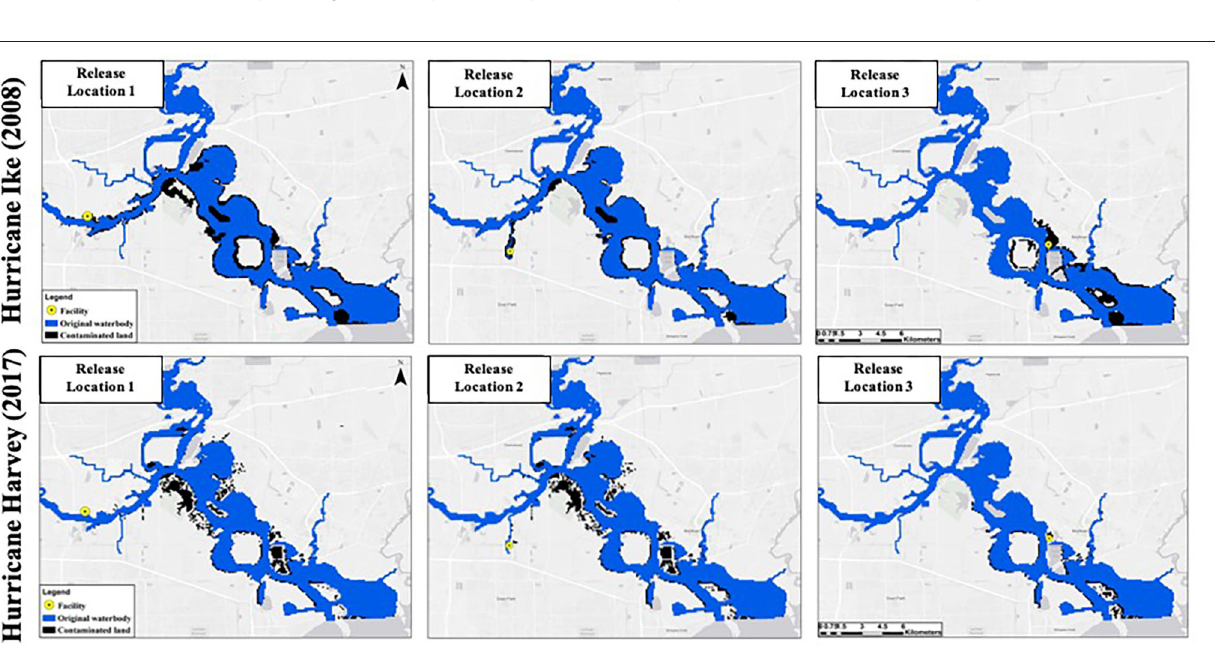
FEDERAP Projected